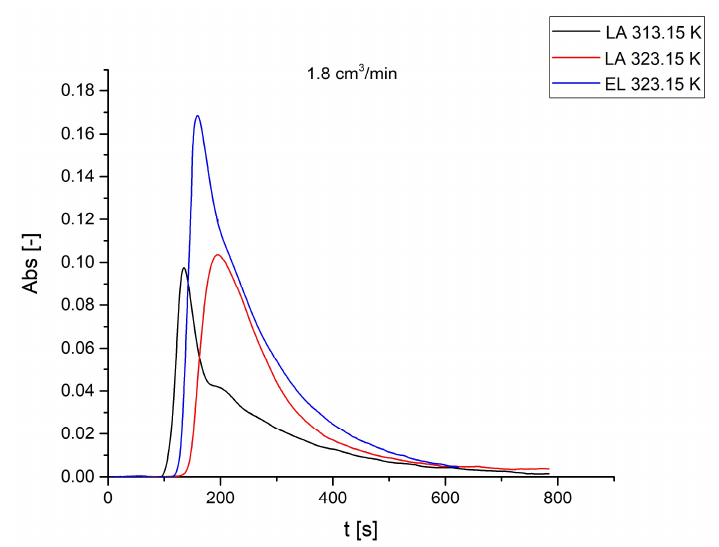
Figure 8. UV spectra of LA and EL 6 M at 313 and 323 K at 1.8 cm 3 /min flow rate.